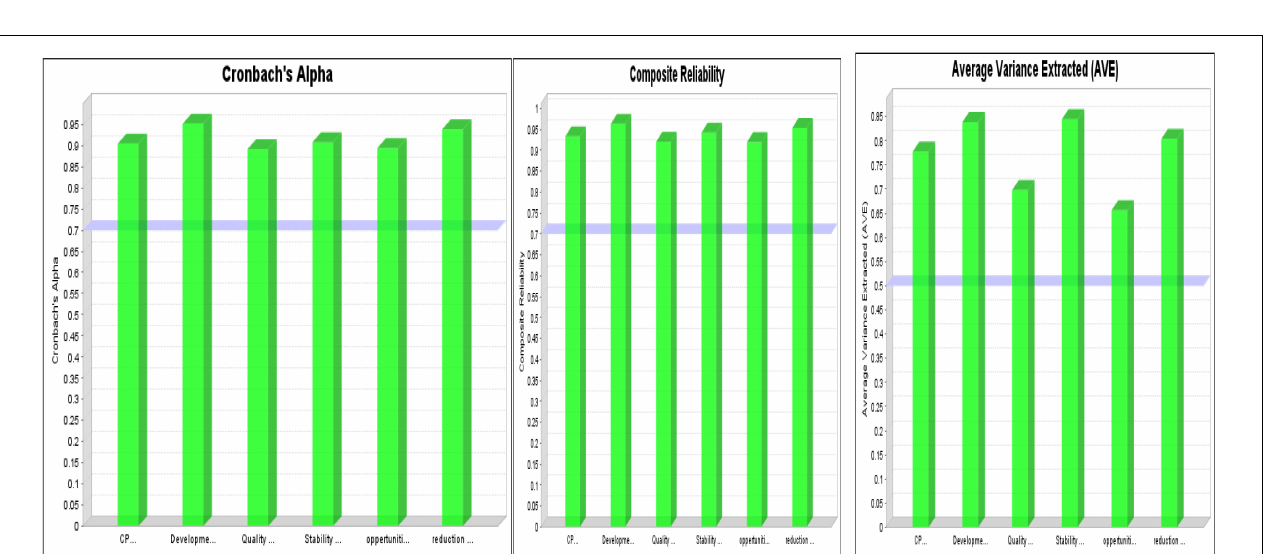
FIGURE 3 | Measurement model (PLS-SEM algorithm). Estimations of structural equations model graphical representation of construct validity and reliability. Graphical presentation of Cronbach’s alpha, composite reliability (CR), and average variance extracted